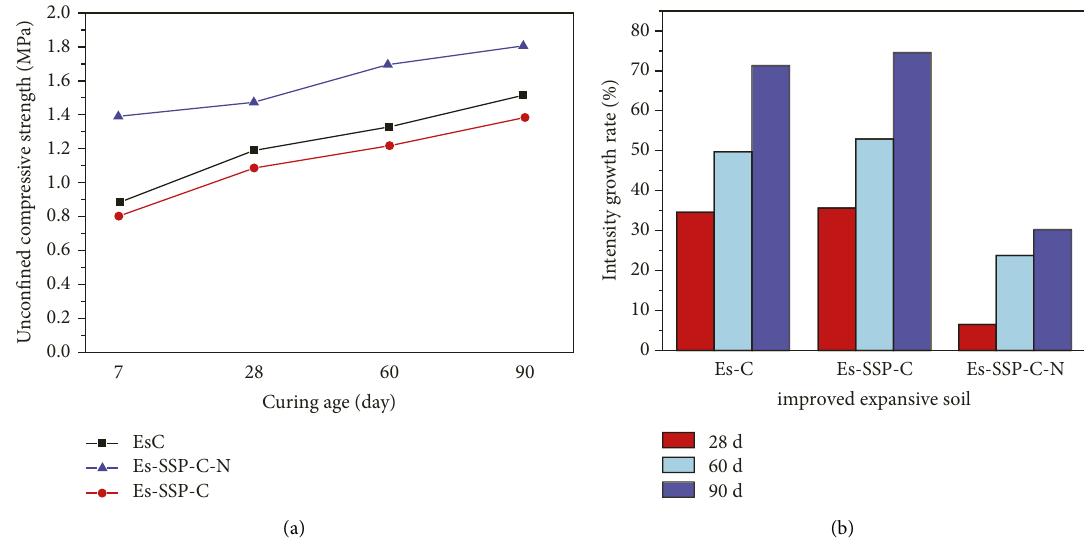
Figure 9: Variation in the unconfined compressive strength and rate of improvement with the curing age for various solidified soil specimens. (a) Unconfined compressive strength; (b) rate of improvement in unconfined compressive